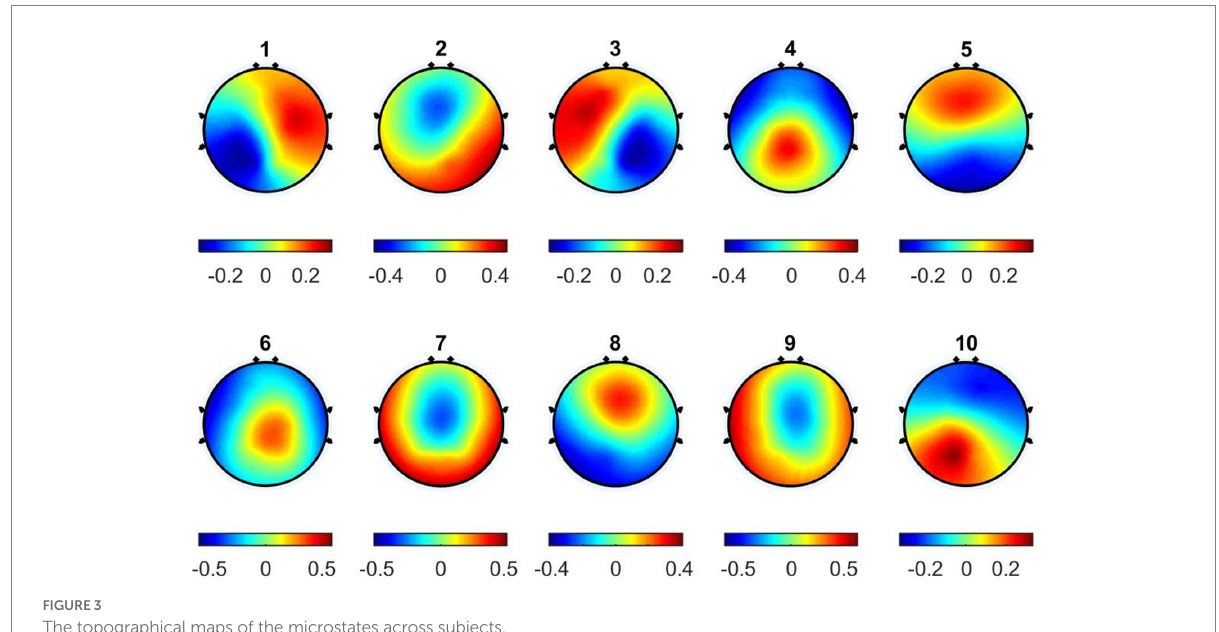
FIGURE 3 The topographical maps of the microstates across subjects.